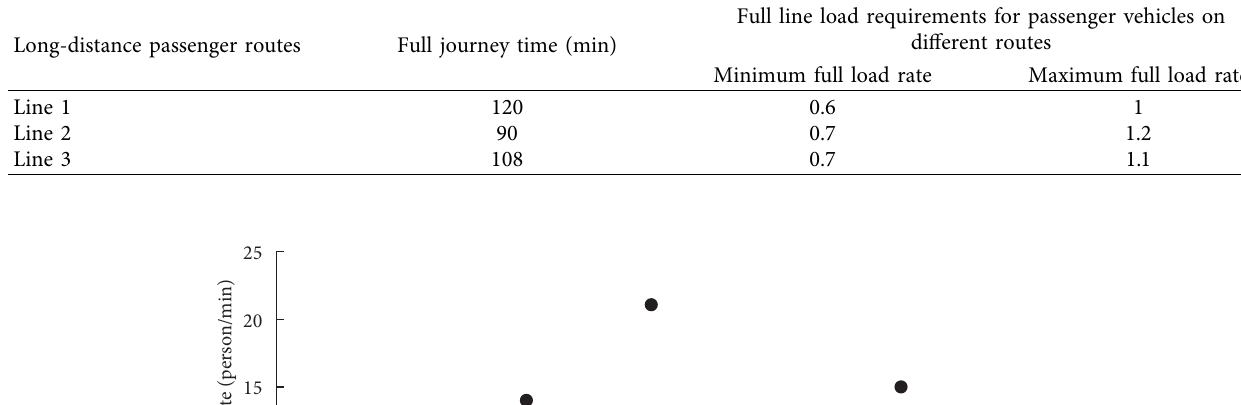
Table 2: Long-distance bus travel time and total load rate requirements.